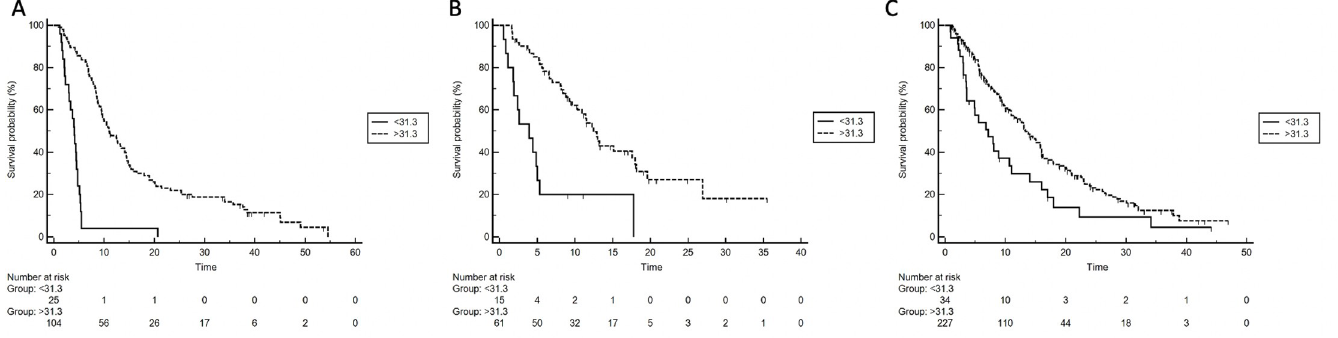
Fig 3. OS according to PNI in the first validation cohort (A); second validation cohort (B) and third validation cohort (C). https://doi.org/10.1371/journal.pone.0232449.g003 The participants in a second validation cohort were 76 patients collected in the Innovate